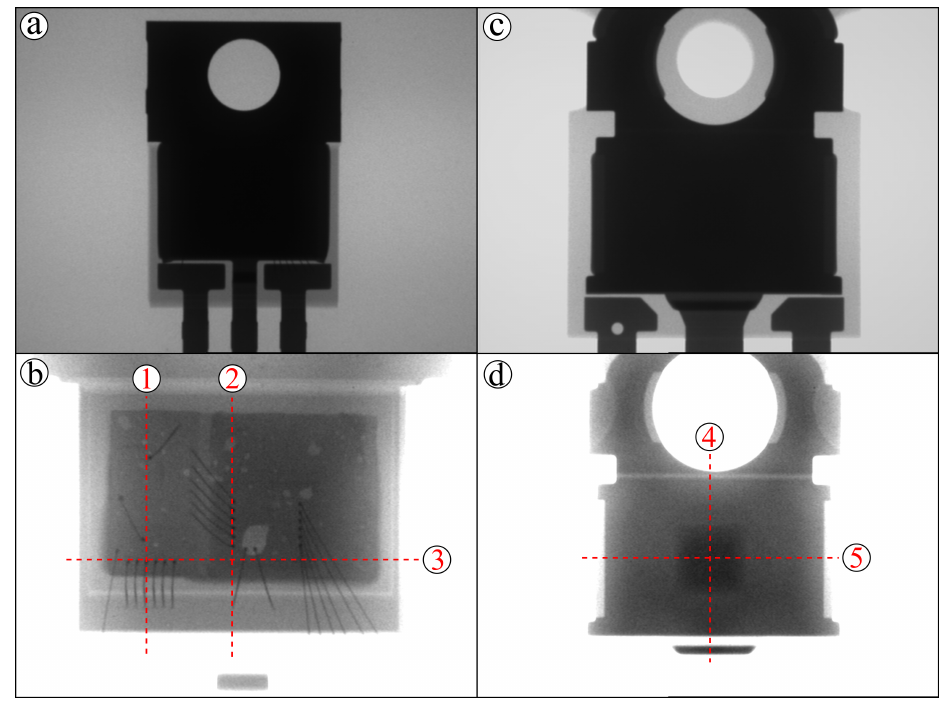
Figure 5. X-ray imaging of the ( a , b ) GaN cascode MOSFET and the ( c , d ) SiC MOSFET with the (1)–(5) cross-sections made for the